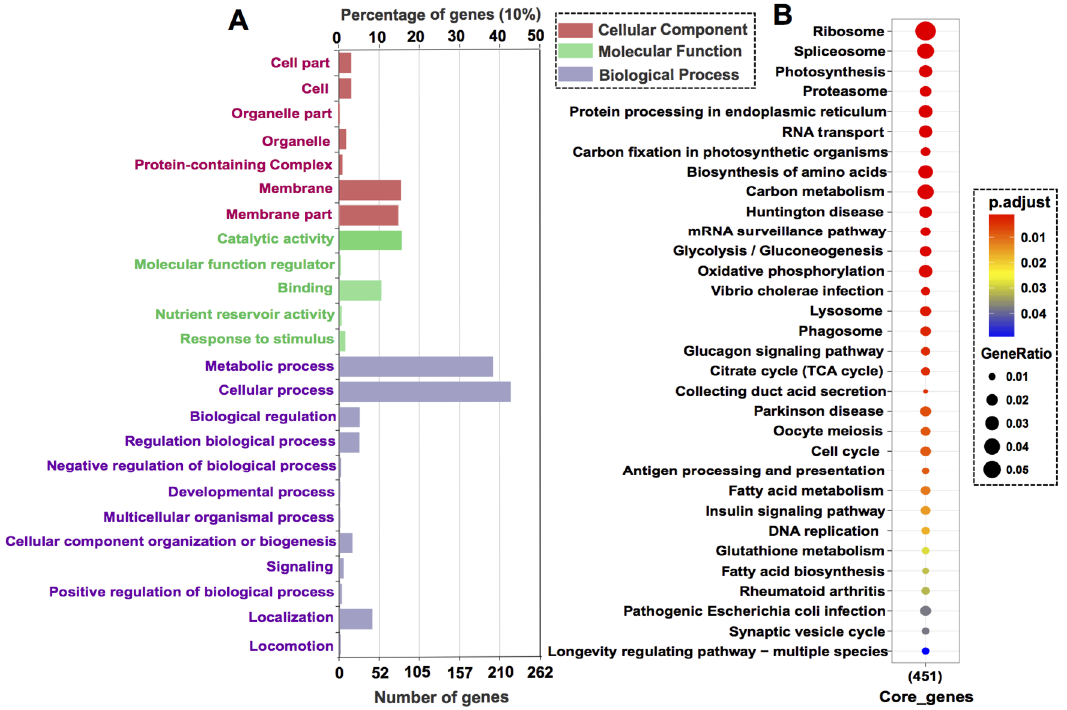
Figure 3. GO annotation and KEGG pathway enrichment of core genes: ( A ) GO annotation category (level 1 Go terms). ( B ) KEGG pathway enrichment with the p -value cuto ff = 0.05. Dot size represents enriched DEGs count; color strength represents the p -value (from lowest in red to highest in